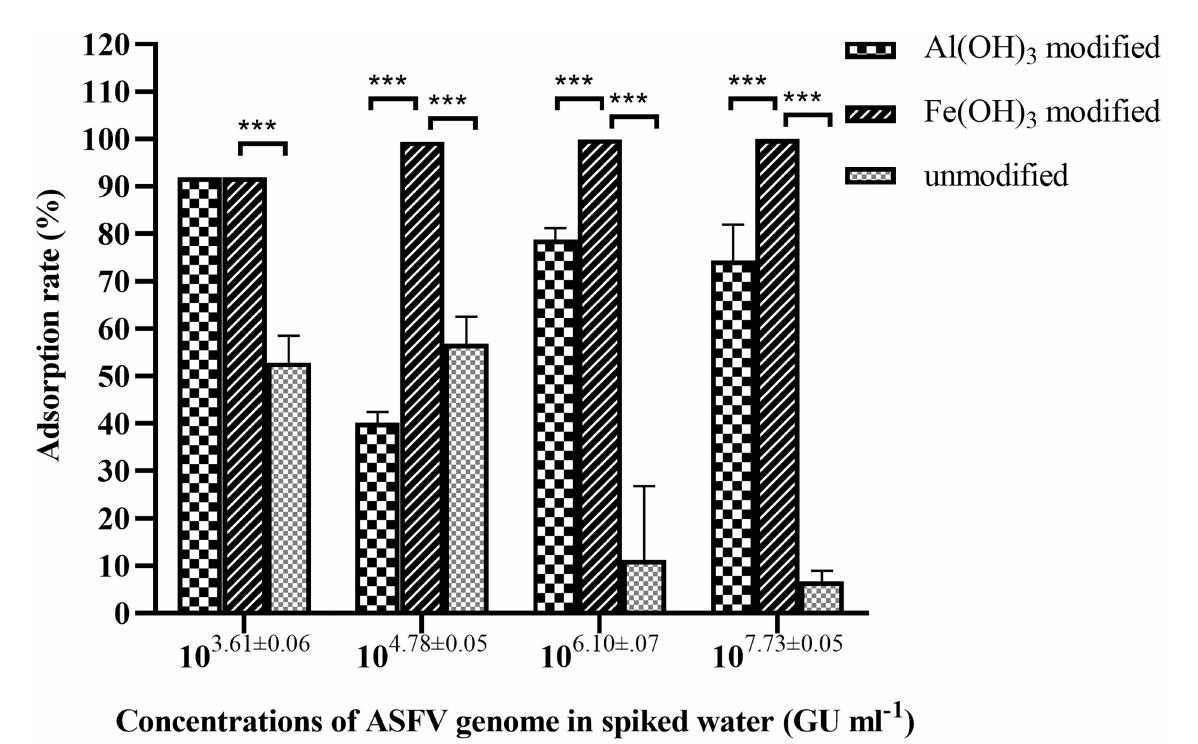
FIGURE2 Adsorption of ASFV by Al(OH) 3 -modified, Fe(OH) 3 -modified, and unmodified diatomaceous earth from 40ml of spiked water containing different concentrations of virus. The adsorption efficiency of the Fe(OH) 3 -modified diatomaceous earth was significantly higher than that of the other two materials. ***Significant difference between groups ( p <